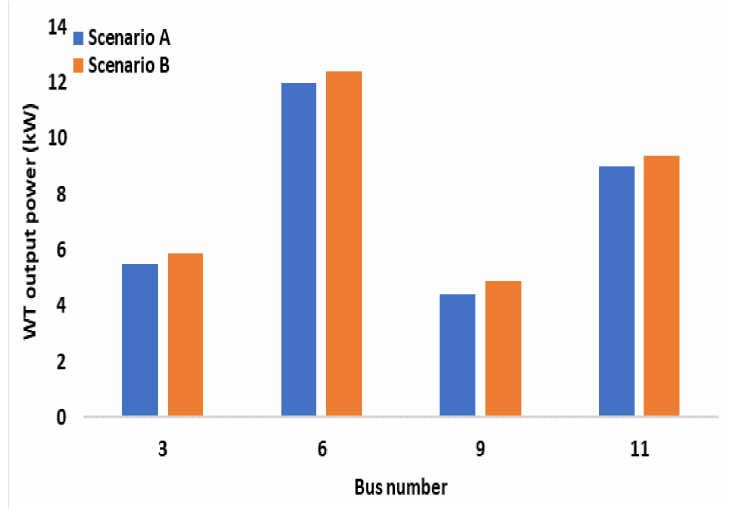
Figure 7. Total active power dispatched by WTs in all scenarios at candidate buses.